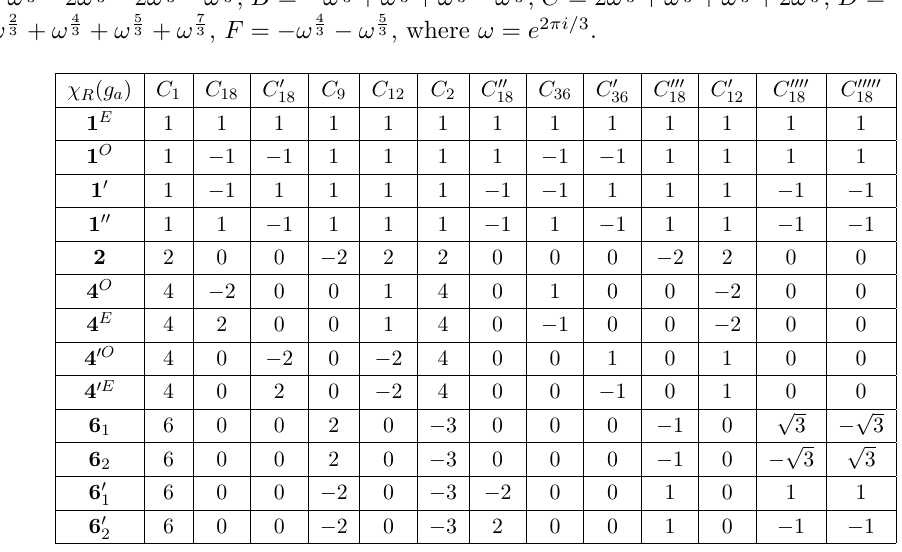
Table 6 . Character table for G o ( Z 2 (cid:2) Z 2 ). The subscripts of the conjugacy classes indicate their